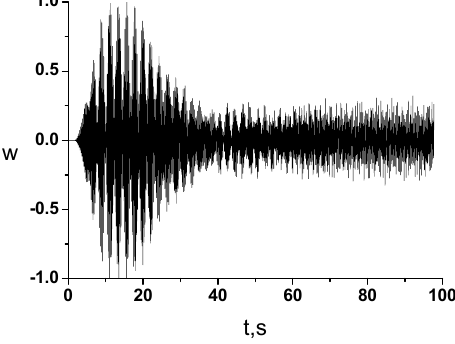
Figure 6. The scaling factor is equal to 2.